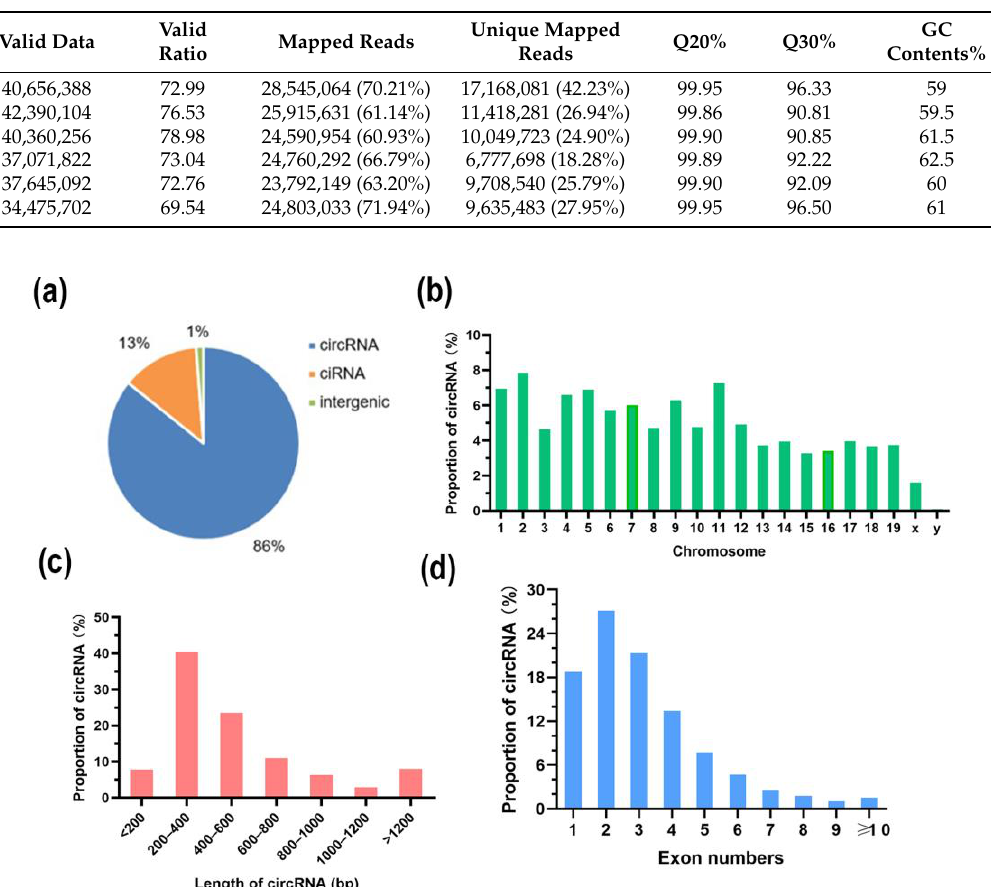
Table 1. Statistics of RNA-seq data.